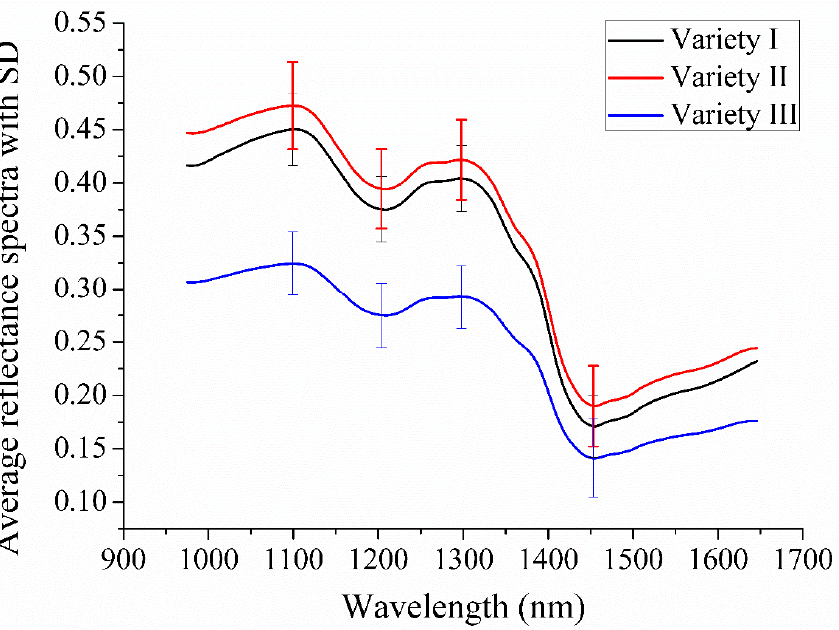
Figure 1. The average spectra of grape seeds of three varieties in the range of 975–1646 nm. SD: standard deviation.